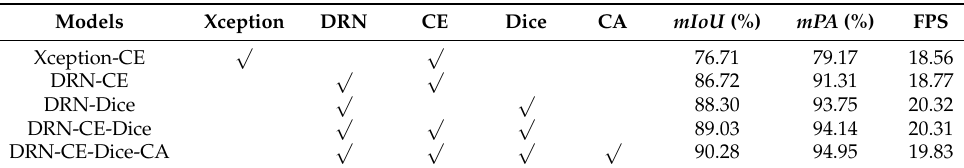
Figure 6. mIoU curves of the ablation experiment. Table 2. A comparison of the ablation